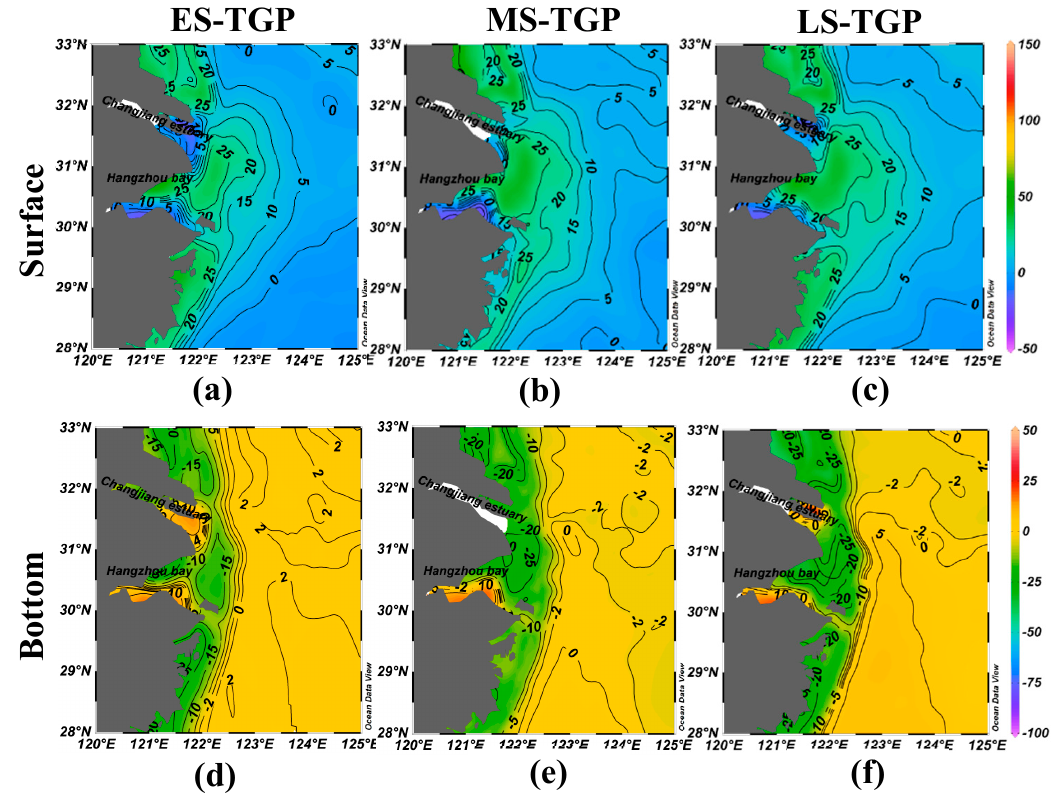
Figure 9. Spring biological e ff ect of the POC in the Changjiang Estuary and adjacent East China Sea. ( a – c ): Surface e ff ects during ES-TGP, MS-TGP and LS-TGP, respectively; ( d – f ): Bottom e ff ects during ES-TGP, MS-TGP and LS-TGP,